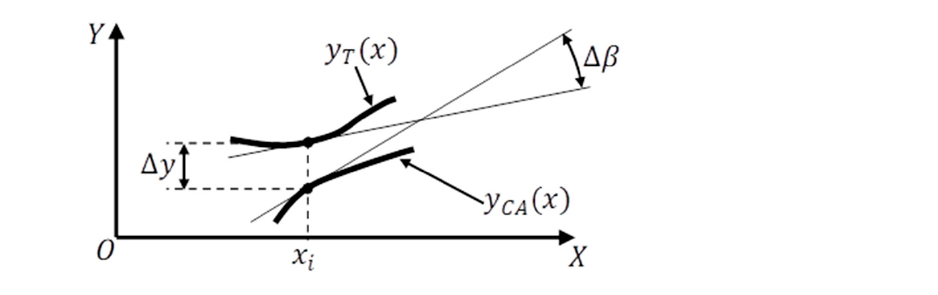
Figure 4. Illustration for determining ∆ y and ∆ β based on the course of the y T ( x ) and y CA ( x ) curves at point x i .